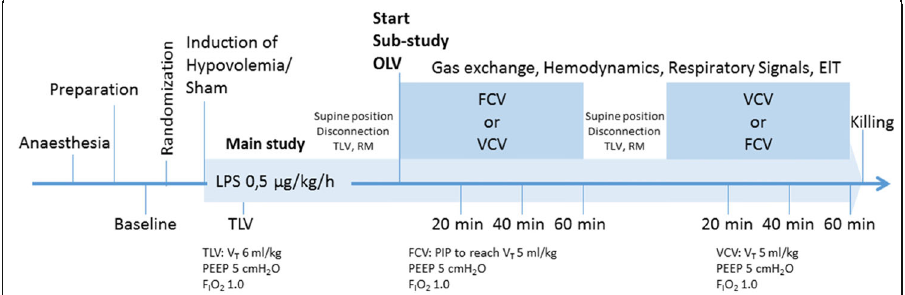
Fig. 1 Time course of interventions and measurements. FCV, flow-controlled ventilation; VCV, volume- controlled ventilation; TLV, two-lung ventilation; LPS, lipopolysaccharide; EIT, electrical